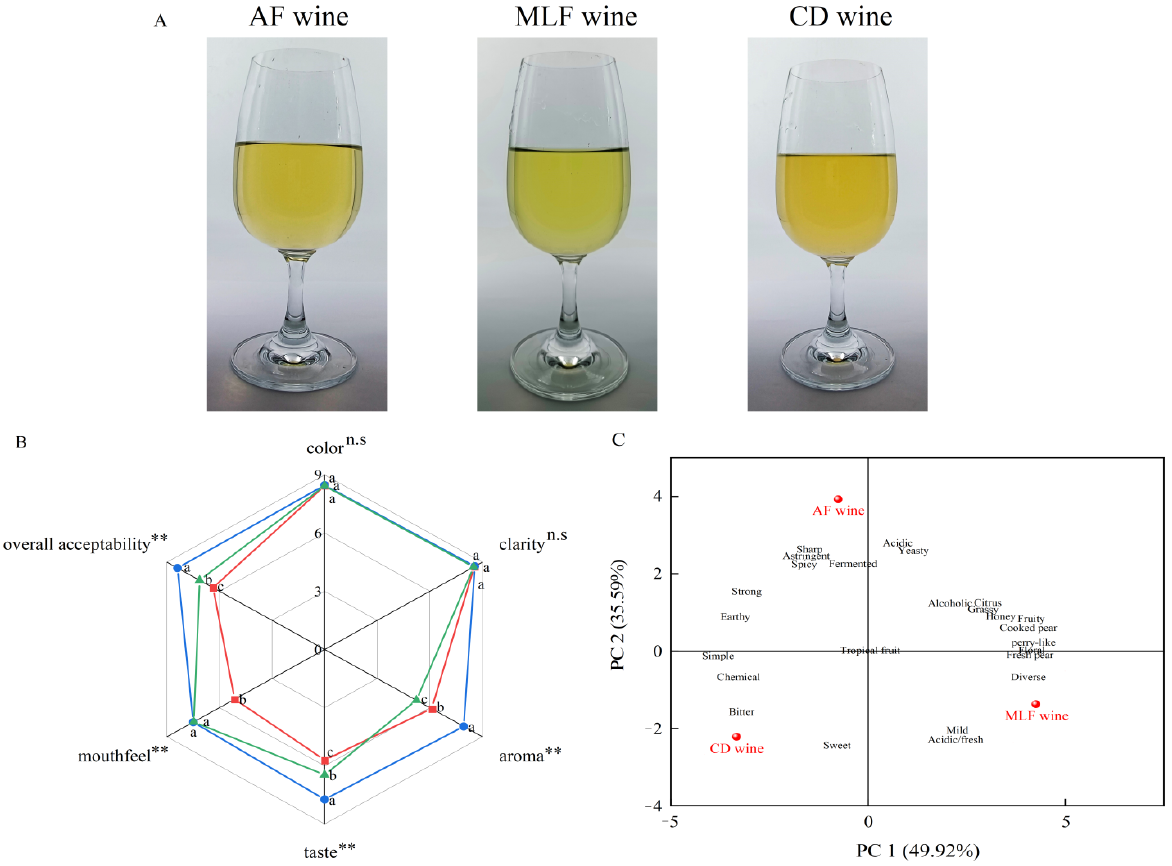
Figure 5. Sensory characteristics of pear–kiwifruit wine with and without deacidification treatment: ( A ) fruit wine samples; ( B ) sensory profiles obtained for AF wine (—), MLF wine (—), and CD wine (—); ns = not significant, ** p < 0.01, values with different letters are significantly different among the samples; ( C ) principal component analysis for check-all-that-apply attributes; n = 36.